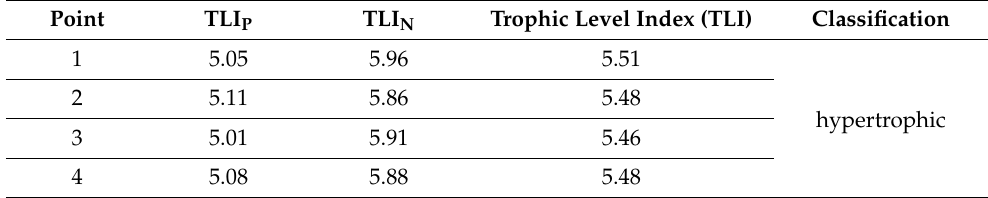
Table 12. Trophic status at the analyzed research points on the Odra River (Poland)—Trophic Level